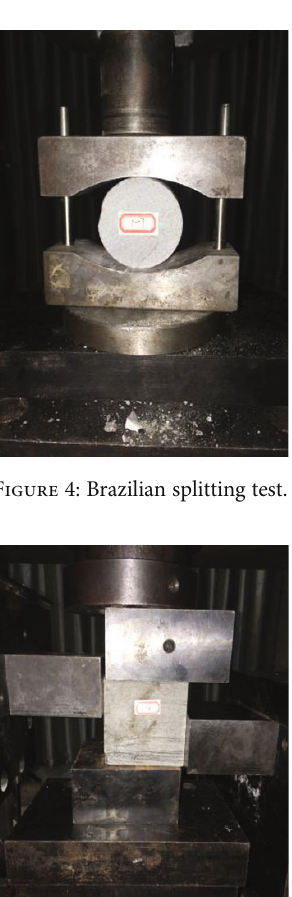
Figure 3: Uniaxial compression test.